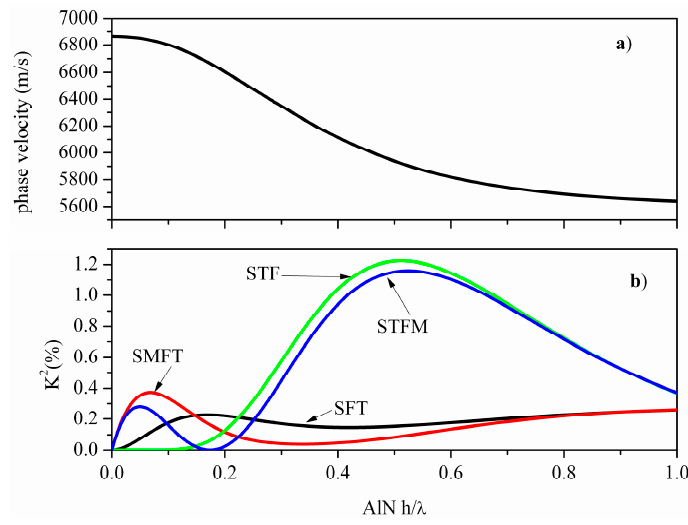
Figure 16. The phase velocity ( a ) and K 2 ( b ) dispersion curves for SAW propagating along the <001> direction of the (110) SiC/AlN substrate. Crystals 2016 , 6 , 25